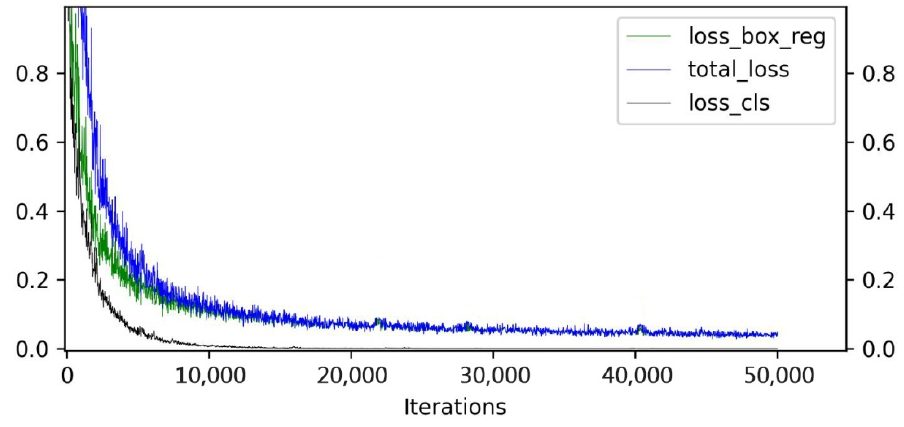
Figure 9. The process of model training on training